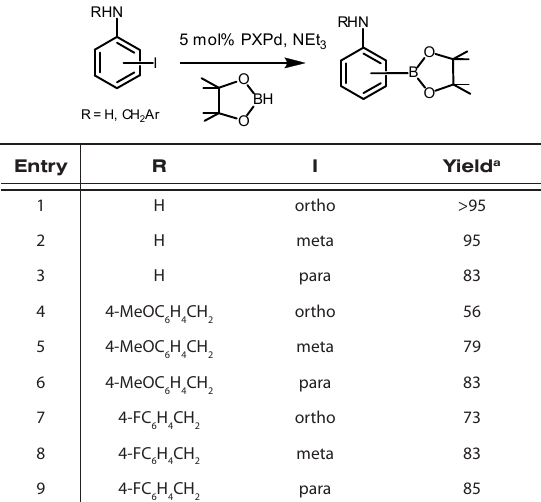
Table 3. PXPd catalyzed borylation of substituted iodoanilines.